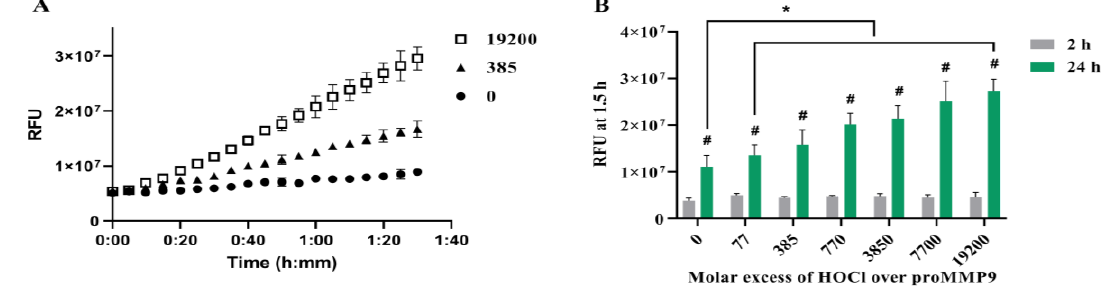
Figure 1. Activation of recombinant human proMMP9 by HOCl. ( A ) Plot of relative fluorescence units (RFUs) against time for reaction of 13 nM proMMP9 exposed to 0, 385- and 19,200-fold molar excesses of reagent HOCl (as indicated, corresponding to 0, 5 µ M and 250 µ M HOCl, respectively) in Assay Buffer A (containing HEPES) for 24 h at 37 ◦ C before addition of the substrate and recording of the fluorescence intensity of the cleaved peptide over a period of 90 min at 5 min intervals. ( B ) RFUs detected on incubation of proMMP9 with the indicated molar excesses of HOCl for 2 h (grey bars) or 24 h (green bars) at 37 ◦ C before addition of the profluorescent substrate and analysis of fluorescence from the cleaved peptides (cf. Panel A, and Section 2). Data are presented as mean values ± SDs from three independent experiments. Statistical analysis in Panel B was performed using two-way ANOVA with Š í d á k’s multiple comparisons test (#), and two-way ANOVA with Dunnett’s multiple comparisons test (*). * Indicates statistical significance against the nontreated control sample after 24 h incubation. # Indicates statistically significant differences ( p < 0.05) between the 24 h- and 2 h-treated samples at the same molar excess of